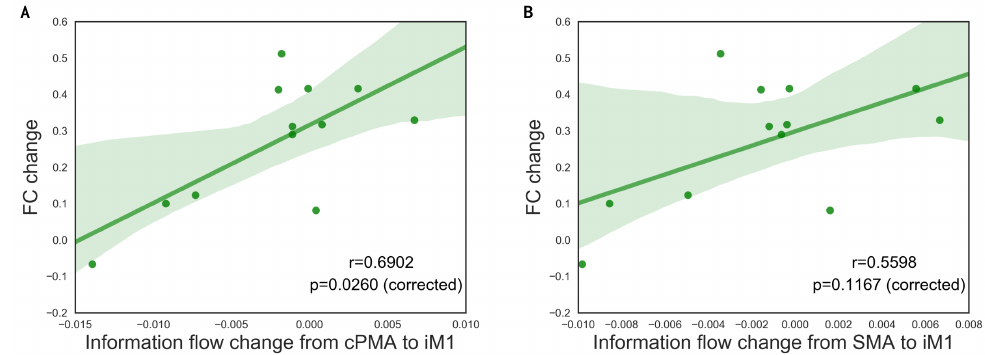
Figure 4. The correlation between functional connectivity change and information flow change from ( A ) cPMA to iM1, ( B ) SMA to